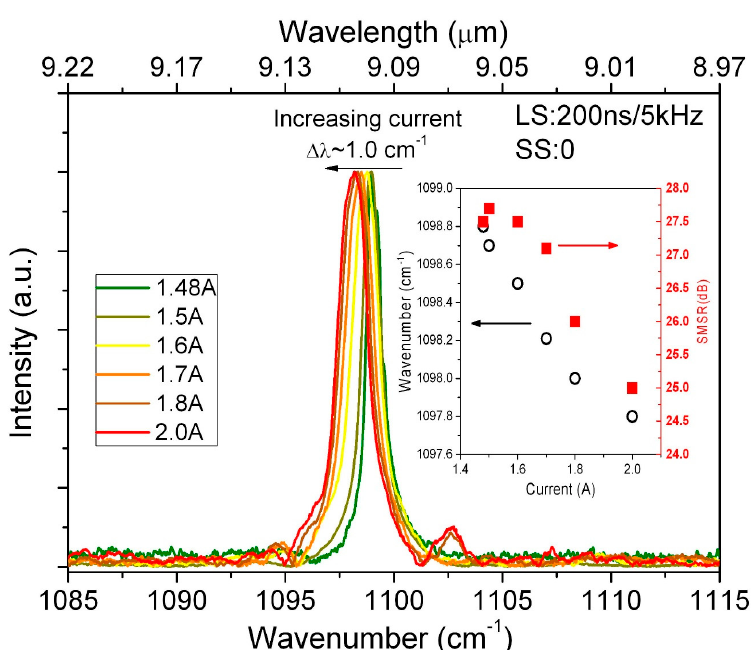
Figure 8. Emission spectra for RIE fabricated CC-QCL for currents starting at the threshold current 1.48 A (6.4k A / cm 2 ) up to 2.0 A (8.6 kA / cm 2 ). Device operated in pulse mode with pulse width 200 ns and repetition rates 5 kHz, with the short section unbiased. The color coding of individual spectra refers to particular points on L–I characteristics, as indicated in Figure 5a.